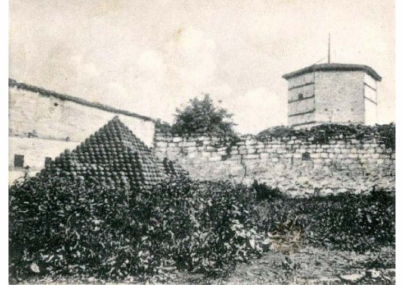
Figure 8. Old Tower Dzephana (Photo source: private archive of Vladan